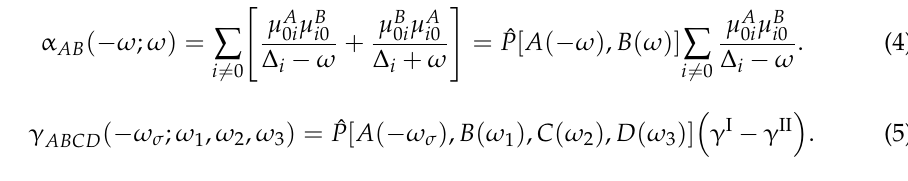
Figure 9. Vibration modes of [12,12]CNB at 929.5, 1360.3, 1482.7, 1565.3, and 3198.8 cm −1 .